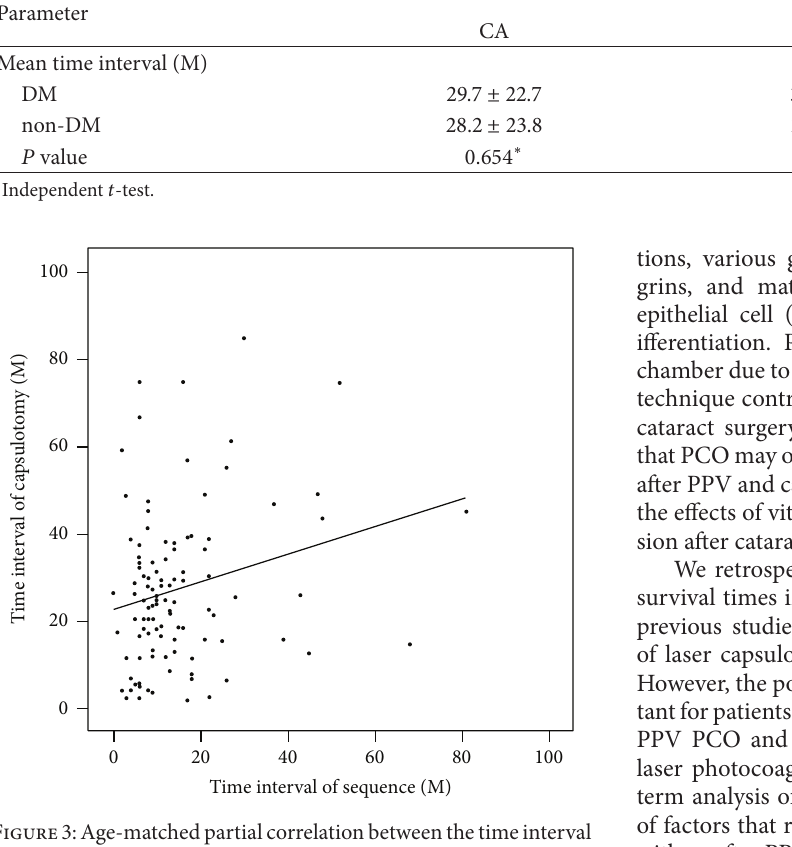
Figure3:Age-matchedpartialcorrelationbetweenthetimeinterval between the PPV and cataract surgeries and the time interval between the cataract surgery and capsulotomy ( 𝑃 = 0.009 , 𝑟 = 0.248 ). A longer time interval between PPV and cataract surgeries was associated with a longer time interval from cataract surgery to Nd:YAG